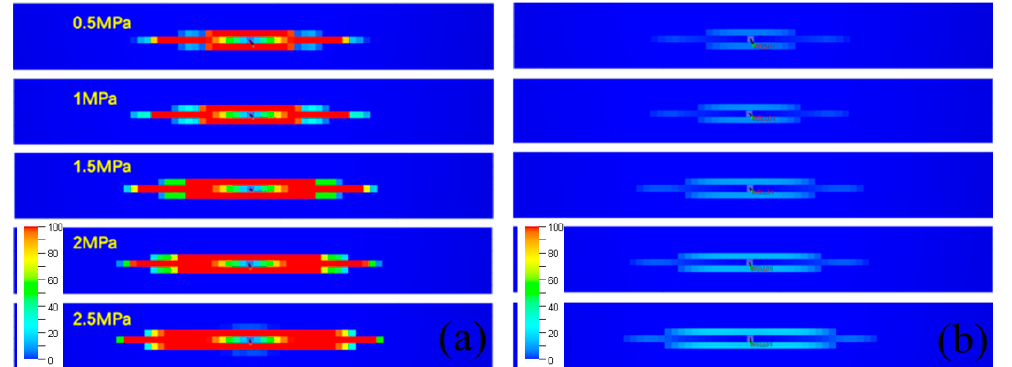
Figure 19. Planar fracture permeability distribution with varying stress difference. ( a ) After fracturing; ( b ) after 6 years of production.